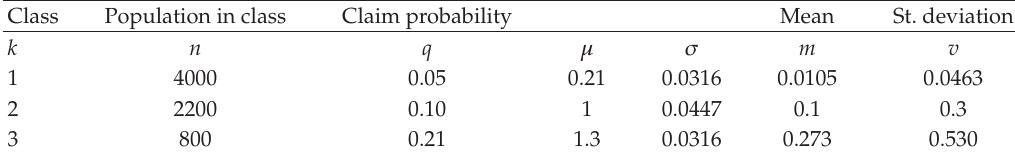
Table 1: Application parameters. The amounts are in